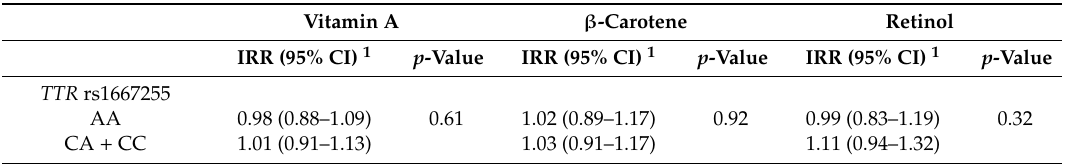
Table 4. Interactions between polymorphisms and dietary intake of vitamin A, β -carotene, and retinol and risk of colorectal